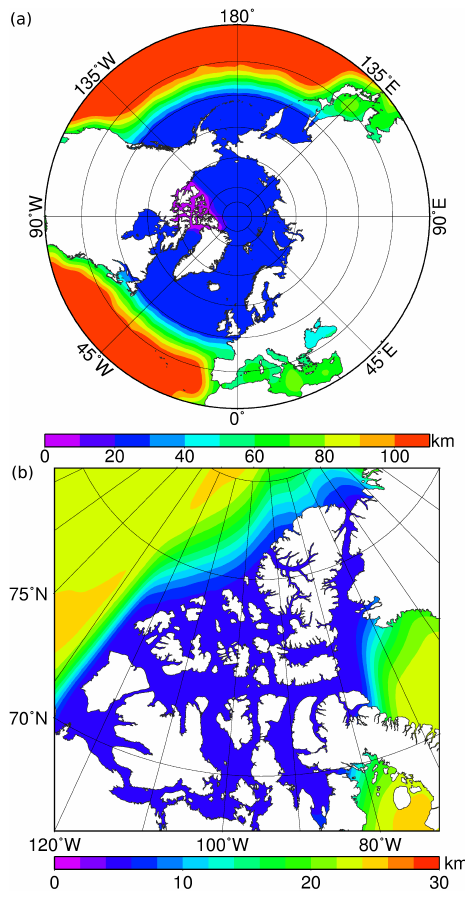
Fig. 14. Horizontal resolution of an example mesh with the CAA Fig. 4. Horizontal resolution of an example mesh with the CAA re- region refined: (a) view in the stereographic projection and (b) gion refined: (a) view in the stereographic projection and (b) close- zoomed to the CAA region. up of the CAA